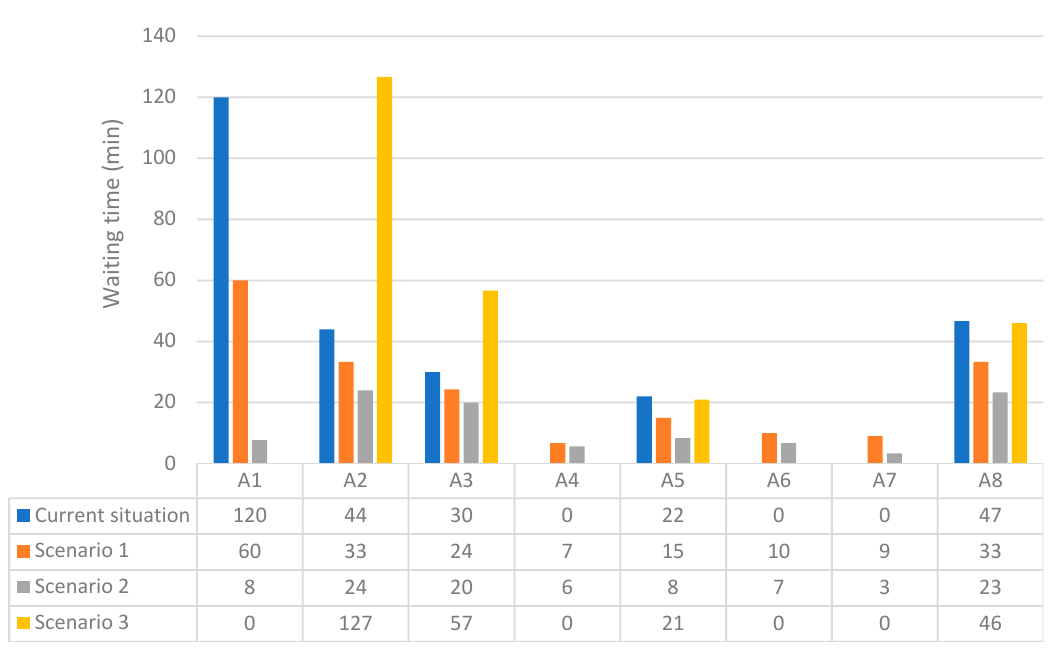
Figure 10. Waiting times after the third scenario implementation.